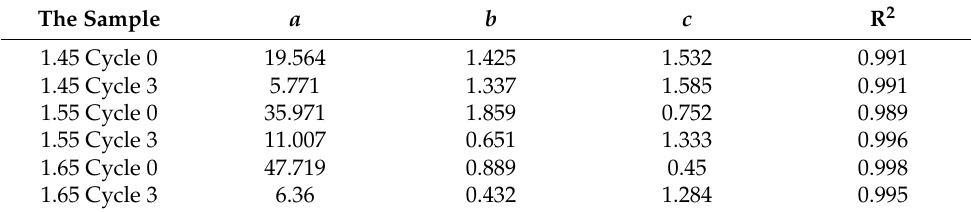
Figure 4. SSCC of compacted loess samples. Table 3. Fitted SSCC parameters from the loess samples